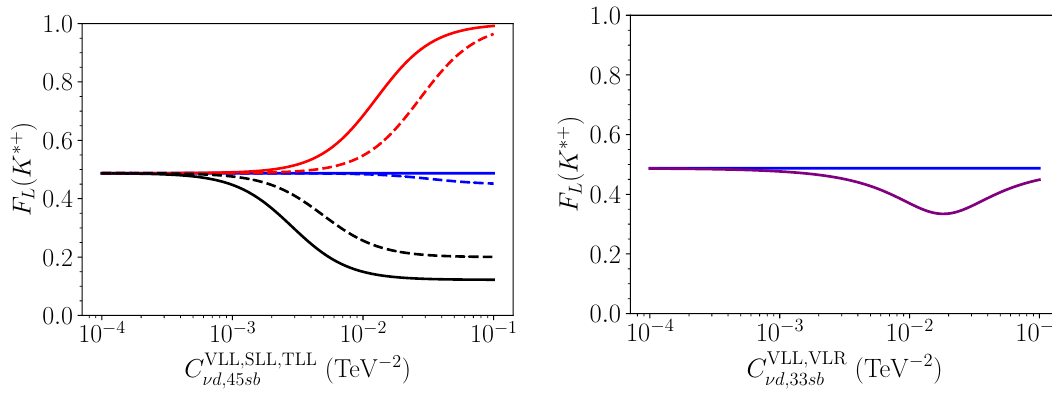
Figure 5 . Binned longitudinal polarisation fraction F L ( K ∗ + ) as a function of one new-physics Wilson coefficient at a time (including the SM contribution). On the left-hand side the blue (red) [black] lines stand for the vector (scalar) [tensor] operator, respectively. Solid [dashed] contours signify m 4 , 5 = 0 GeV [ m 4 , 5 = 1 . 5 GeV]. On the right-hand side the blue (purple) lines stand for